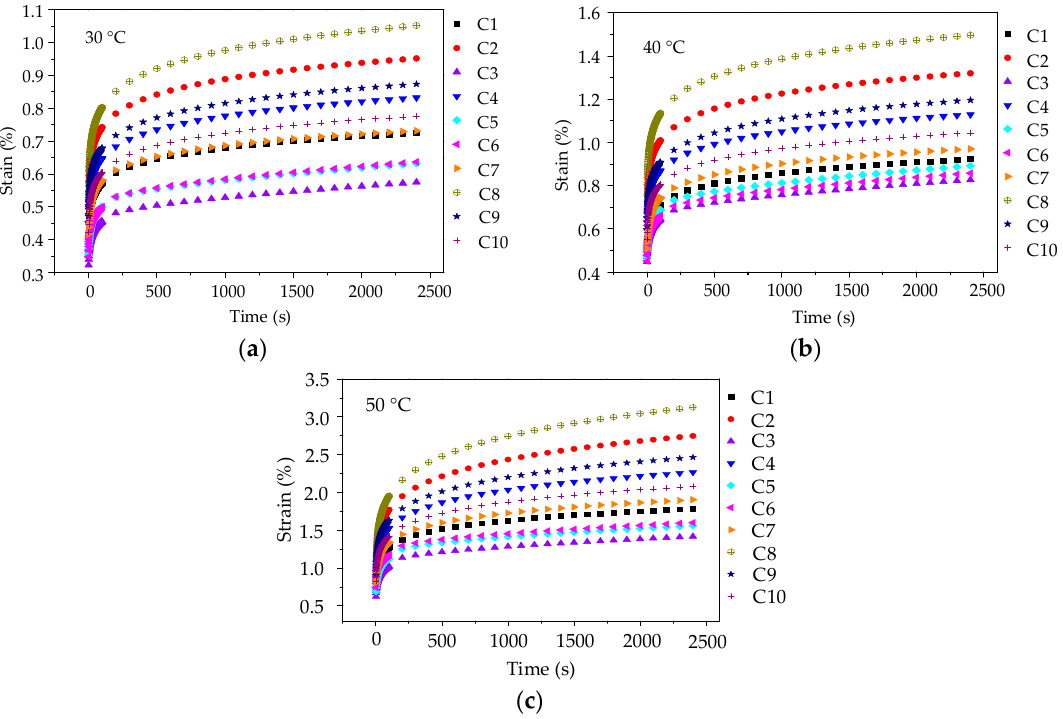
Figure 10. Creep strain ‐ time curves of asphalt mixtures: ( a ) 30 °C; ( b ) 40 °C; and, ( c ) 50 °C.